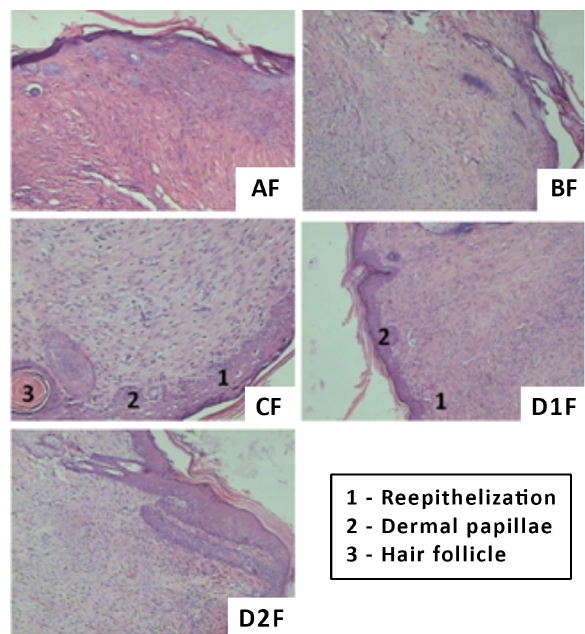
FIGURE 4 - Histological analysis of 14th day of treatment of skin wounds in rats. Key: AF – physiological serum, BF - collagenase, CF – natural PALY, D1F - PALY-CTAC, D2F – PALY-BKC, F – wound.